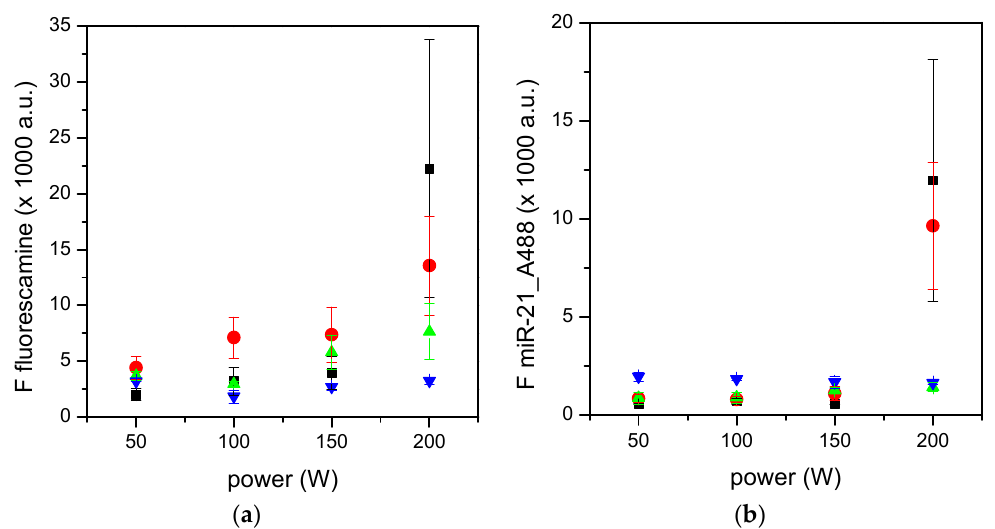
Figure 2. Fluorescamine assay ( a ) and miR-21 adsorption ( b ) on surfaces plasma-coated with binary feeds at varying plasma power levels. Black squares refer to 70:10 CH 4 /NH 3 , red circles refer to 60:20 CH 4 /NH 3 , green upward triangles to 50:30 CH 4 /NH 3 , and blue downward triangles to 40:40 CH 4 /NH 3 . Data are means of at least three surfaces. Standard errors are also reported ( n ≥ 3).